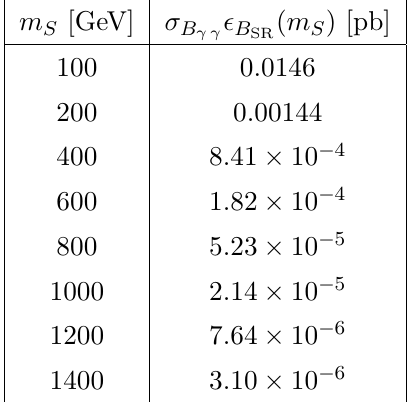
(cid:15) B ( m S ) (in pb) relevant for the (cid:13) (cid:13) (cid:13) (cid:13) (cid:13) (cid:13)